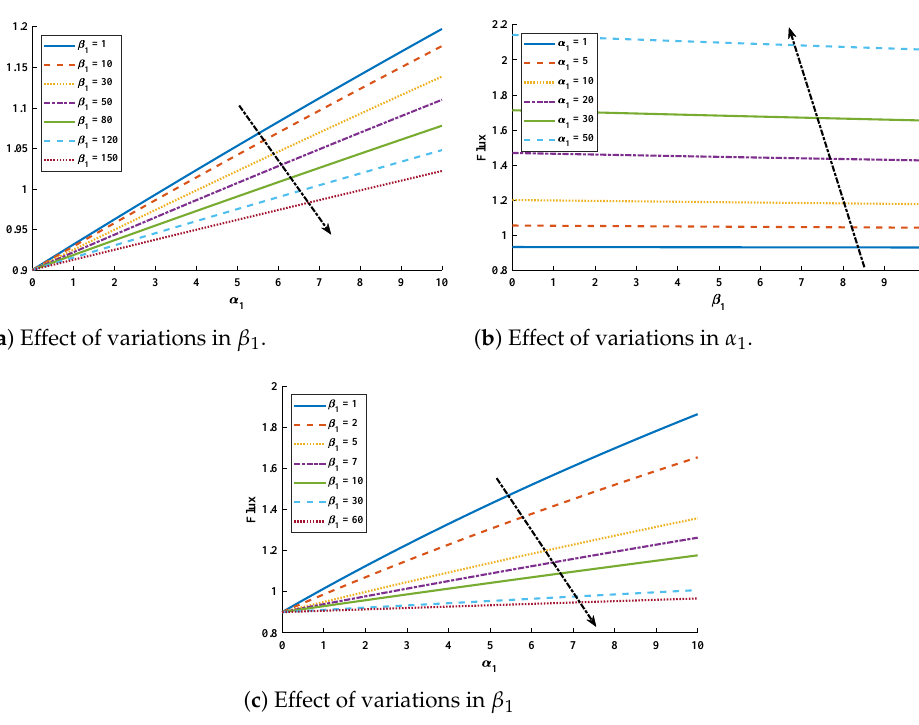
Figure 7. Influence of variations on the normalized parameter flux (enhancement